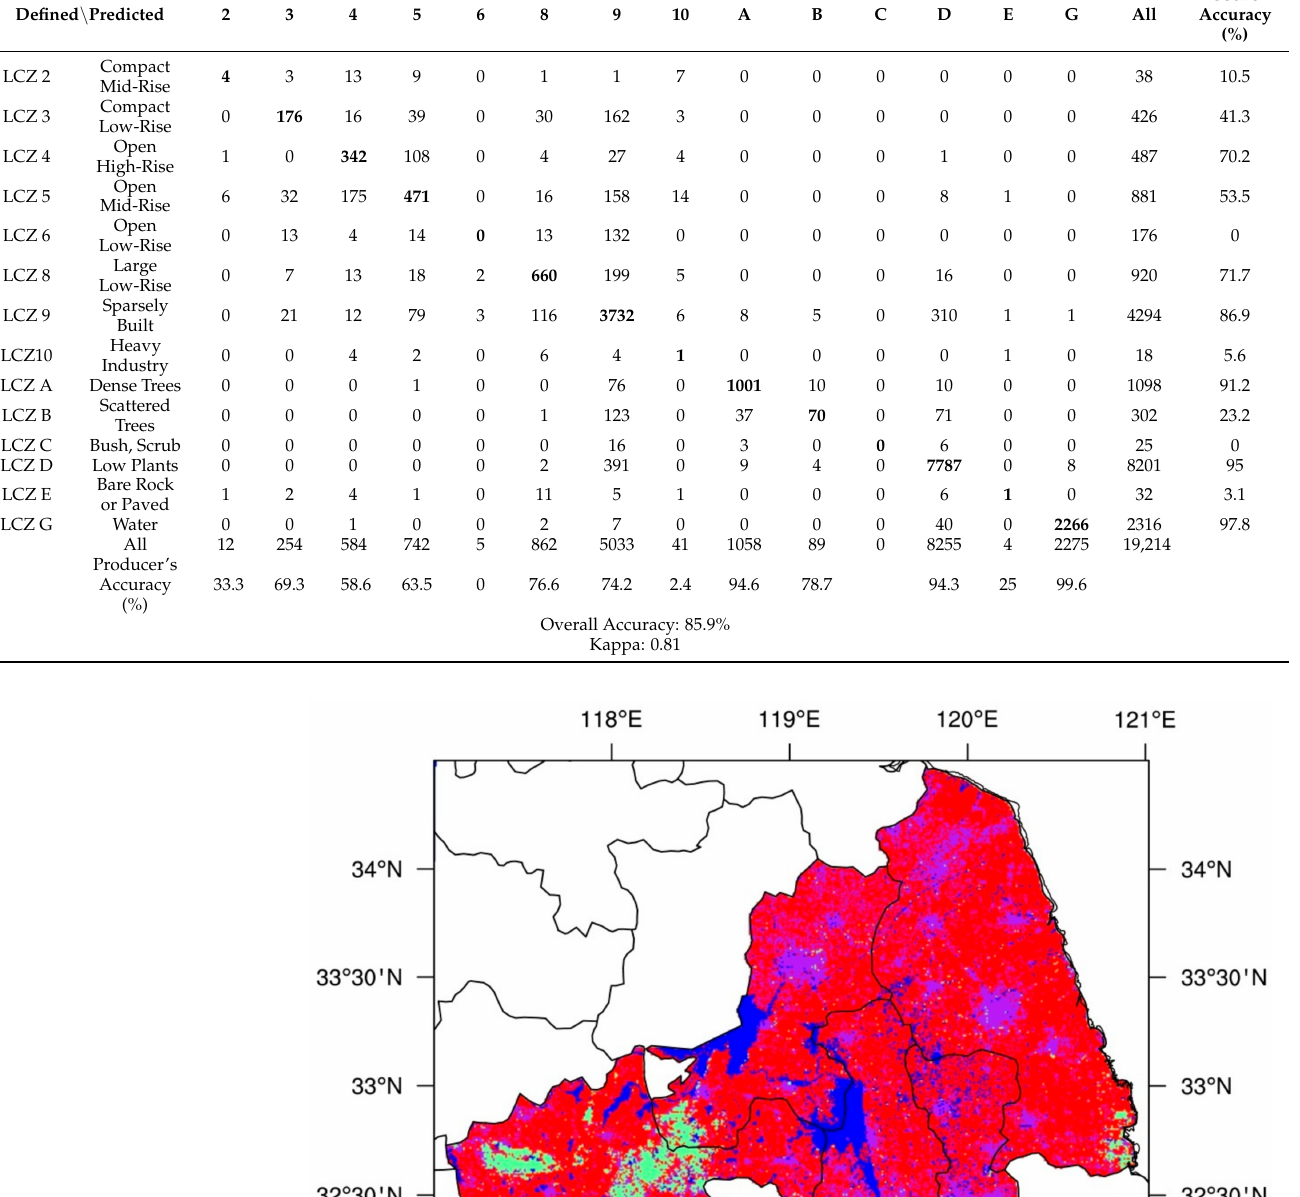
Table 3. Accuracy Matrix for WUDAPT level 0 training areas.